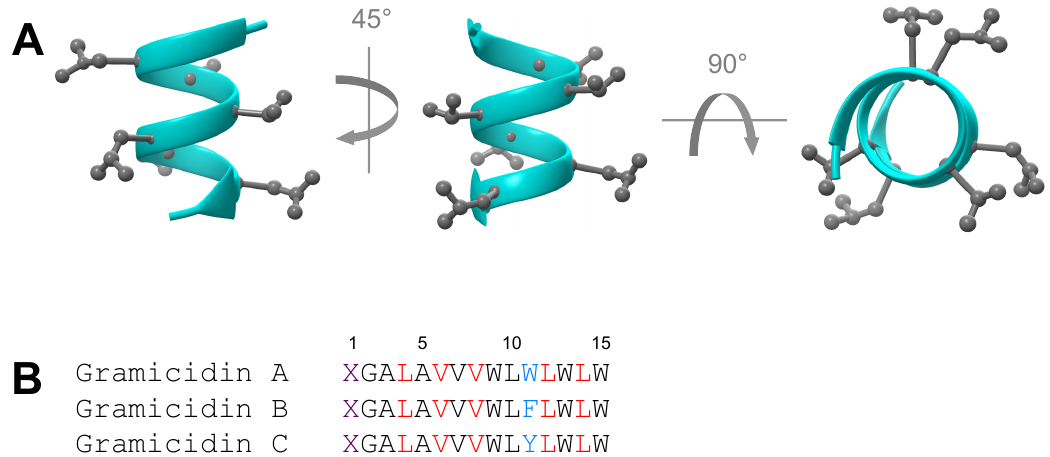
Figure 1. Three-dimensional structure ( A ) and primary sequence ( B ) of Gramicidin D. The first panel shows the protein structure (PDB 1MAG) as a cartoon representation with D -AA shown as grey colored ball-and-sticks. As for the second panel, residues at the first position are represented by purple colored X that can be either valine or isoleucine. Furthermore, L - and D -AA are represented by black and red colored text, respectively, whereas the residue distinguishing the subtype of Gramidicin is indicated by the blue colored